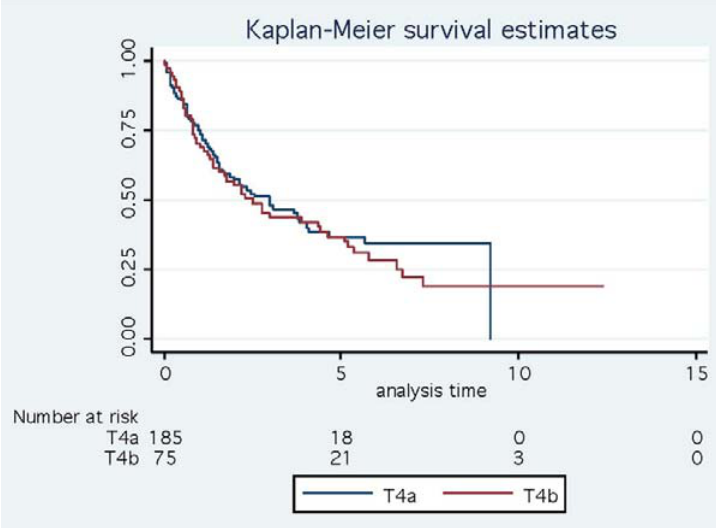
Figure 8. Survival analysis of 260 patients with pT4 colorectal carcinoma. Note that the pT4a and pT4b cases have similar outcomes (pT4a - direct invasion of other structures, pT4b - serosal